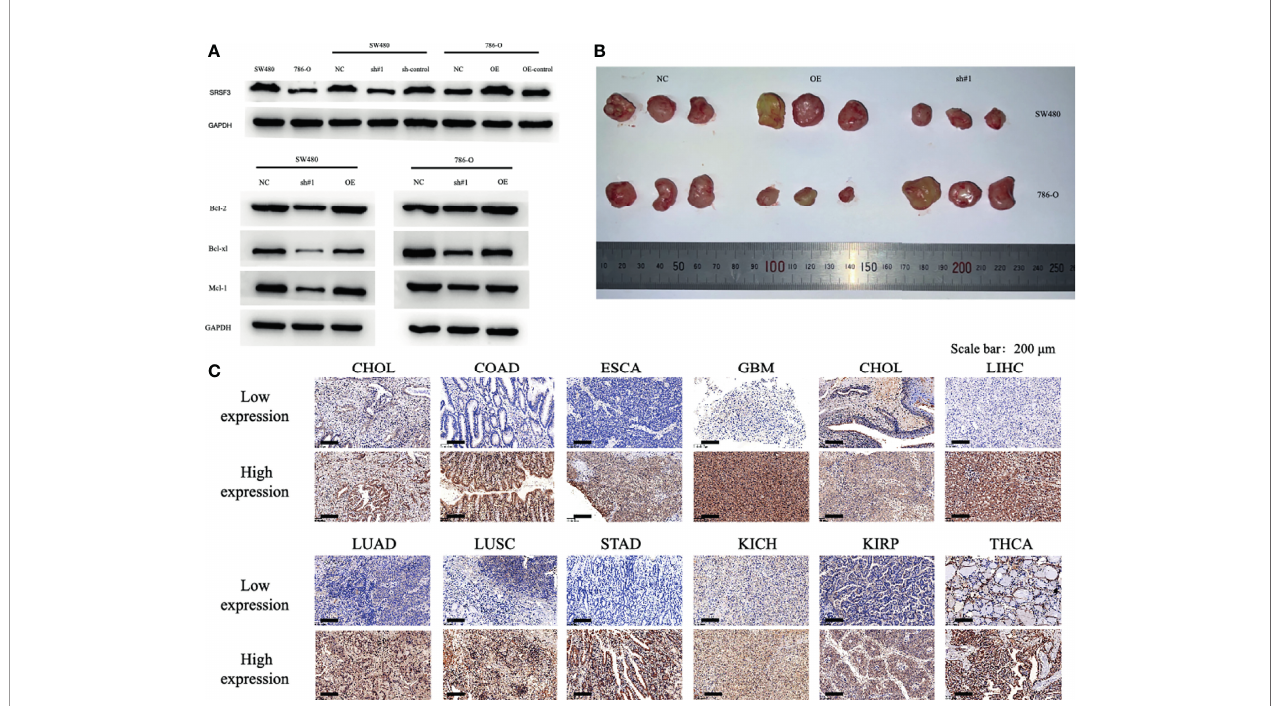
FIGURE 6 | Functional characterization of SRSF3 in vitro / vivo and representative of immunohistochemistry staining of SRSF3 in normal and tumor tissues. (A) Western blot evaluations were used to evaluate SRSF3 expression in SW480 and 786-O and con fi rm the ef fi cacy of transfection. (B) tumor size in mice of NC group, OE SRSF3 group and sh#1 SRSF3 group. (C) Representative western blots of apoptosis related protein expression in SW480 and 786-O cells after transfection. GAPDH as the loading control. High SRSF3 expression in CHOL, COAD, ESCA, GBM, HNSC, LIHC, LUAD, LUSC and STAD tumor tissues. Low SRSF3 expression in KICH, KIRP and THCA tumor tissues. Scale bar: 200